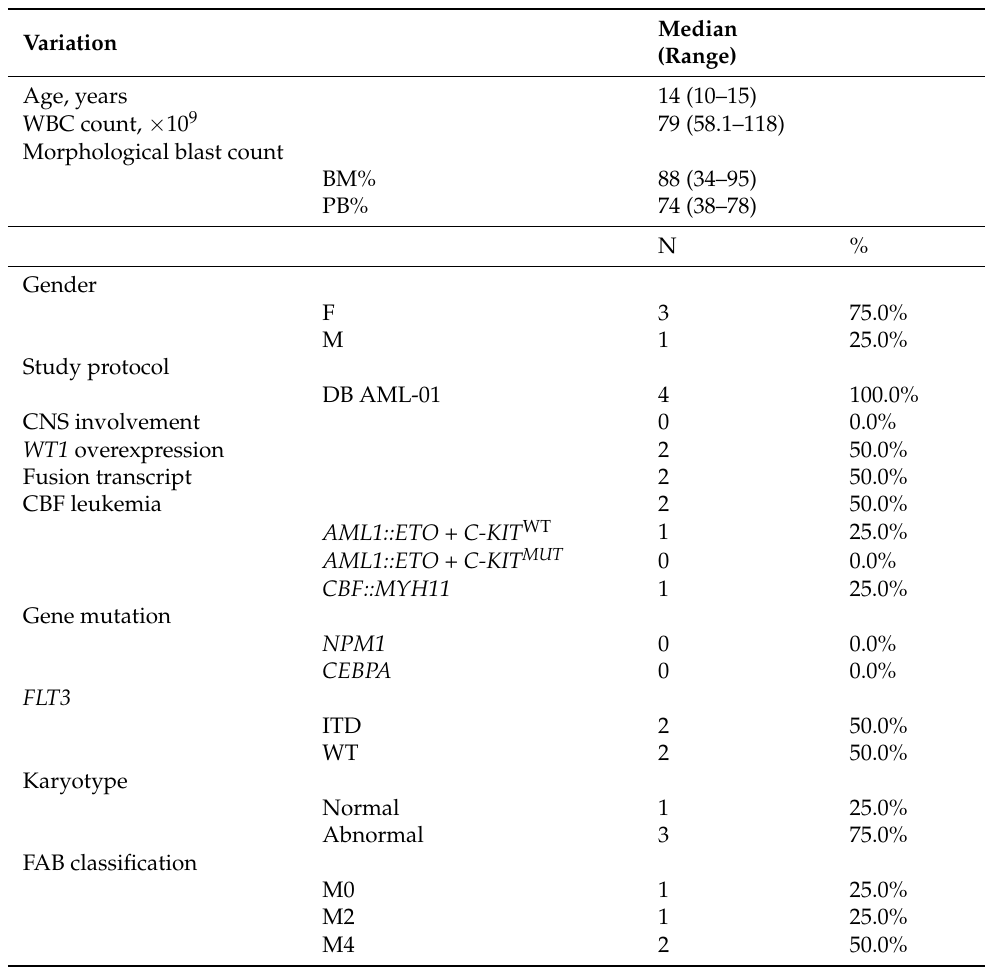
Table 1. Characteristics of four de novo pedAML patients used for the sorting and micro-array profil- ing of CD34+/CD38+ and CD34+/CD38 − cell fractions. Patients were diagnosed in Belgium and classified as standard risk. WT1 overexpression was interpreted in regard to in-house or published (Cilloni et al., 2009)